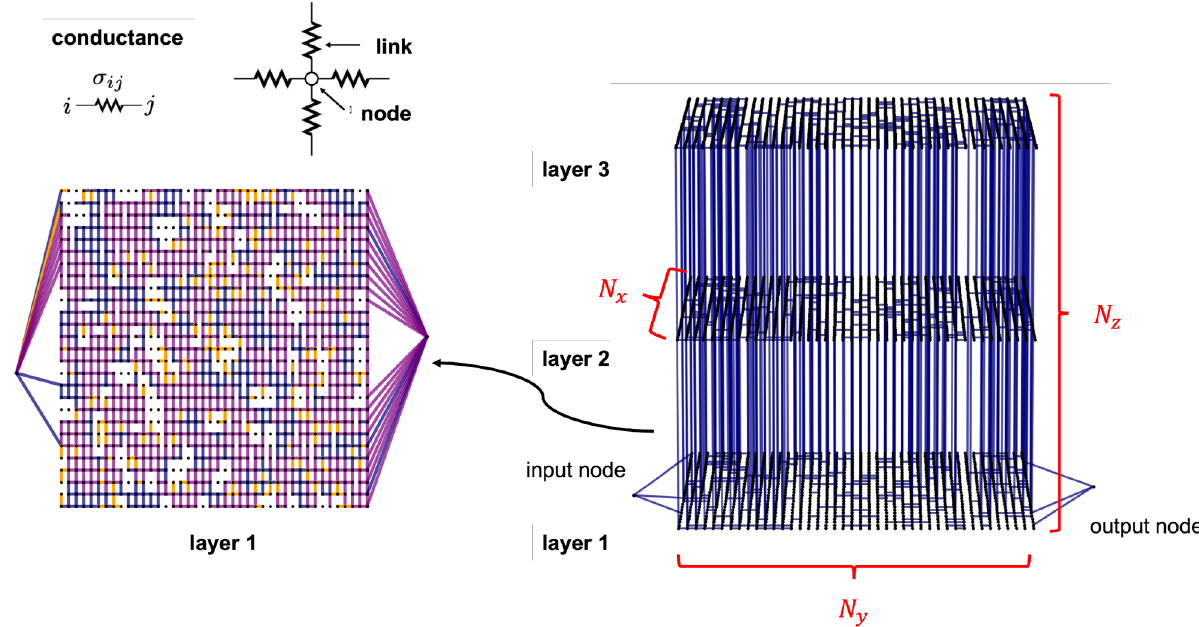
Figure 2. Left: schematization of a node, a link and viem of the layer 1 of the resistor network. Each link can assume one of a discrete number of conductance values (namely, in this work, σ α = 10 − 11 1 � , σ β = 10 − 3 1 � , σ γ = 2 × 10 − 3 1 σ δ = 4 × 10 − 3 1 σ ij = σ α , σ β , σ γ , σ δ are respectively white, � and � ). In the picture, links with orange, blue and purple. Right: 3D view of the full network, where only edges with σ ij = σ γ are colored. N x , N y , N z correspond to the number of nodes along each network direction. Picture realized with NetworkX 44